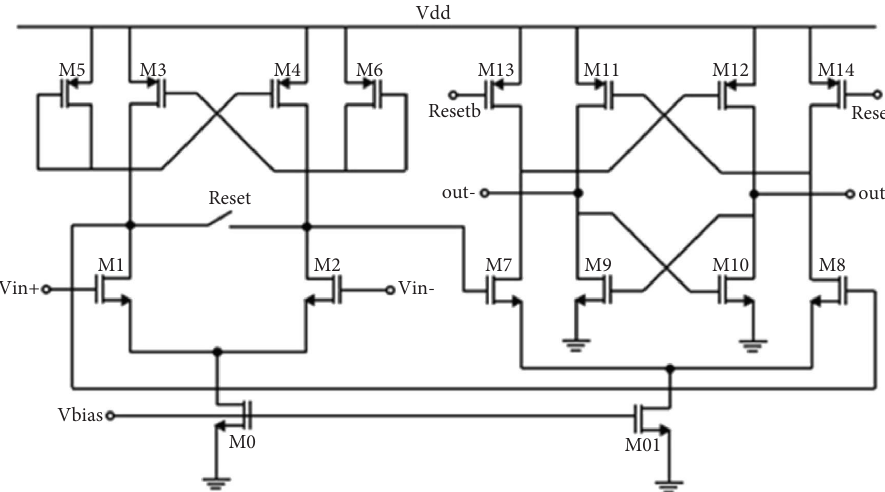
Figure 6: Te two-stage preamplifer and dynamic latch